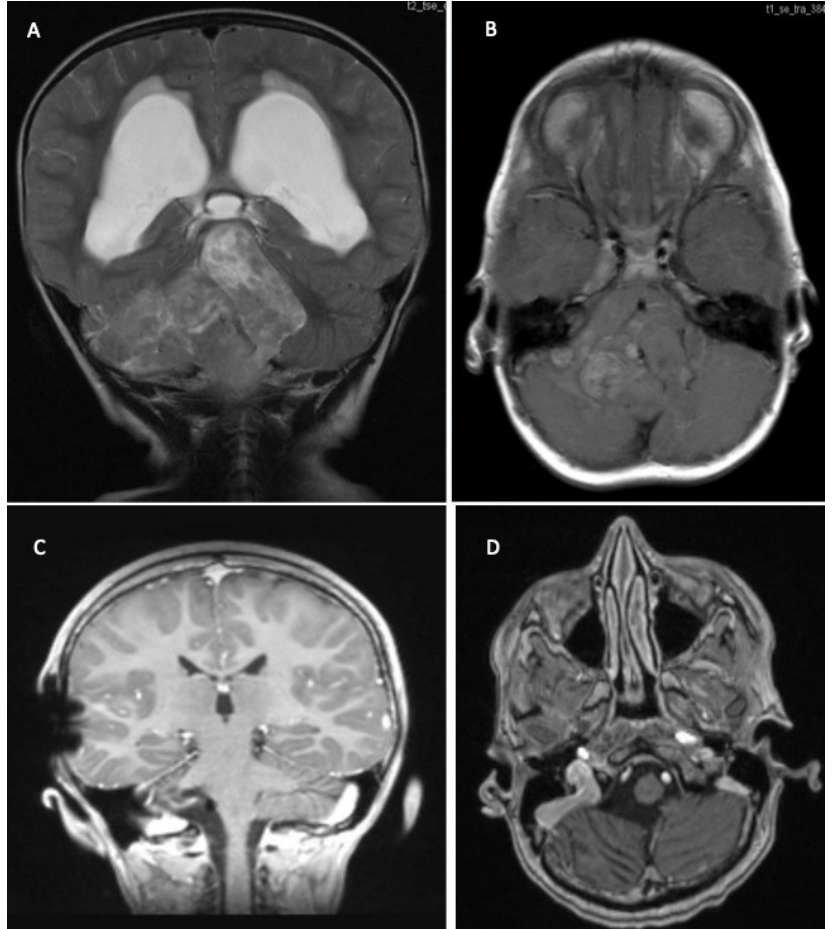
Figure 5. 2 year old boy with psychomotor delay and signs of raised intracranial pressure. T2 ( A ) and contrasted T1 MRI ( B ) shows large posterior fossa tumor and associated hydrocephalus. Diag- nosis: ependymoma without anaplasia (no molecular diagnostic) and shunt implantation. Therapy: GTR ( C , D ) followed by chemo- and conformal radiation therapy. Complete remission for 12 years.